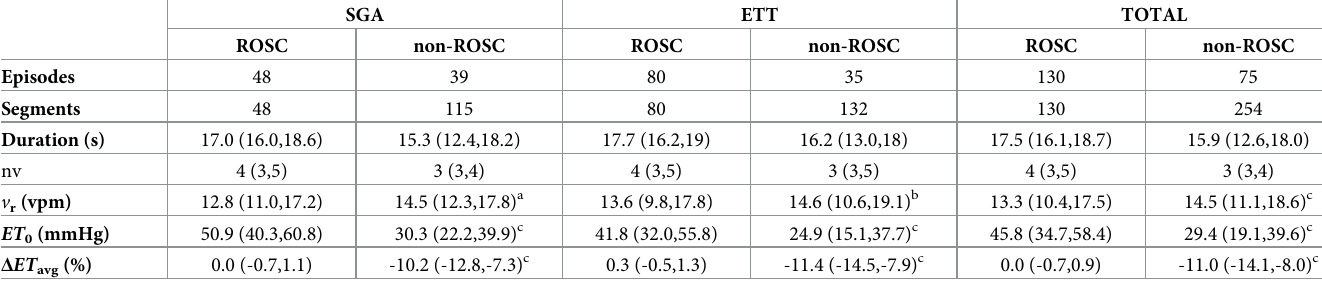
Table 1. Segments characterization as a function of the airway type and ROSC condition. Values are reported as median (IQR).